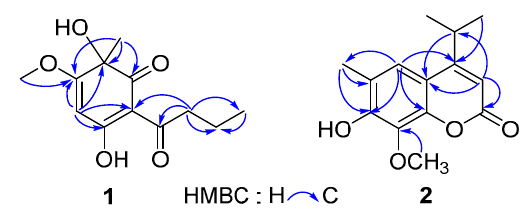
Figure 3. Key HMBC correlations of 1 and 2 .